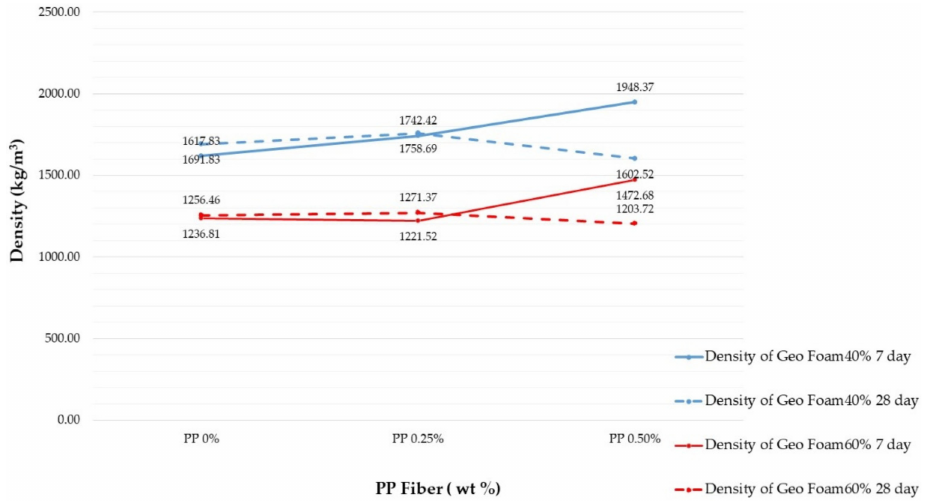
Figure 7. Dry density of fly ash foamed geopolymer with different PP fibers.